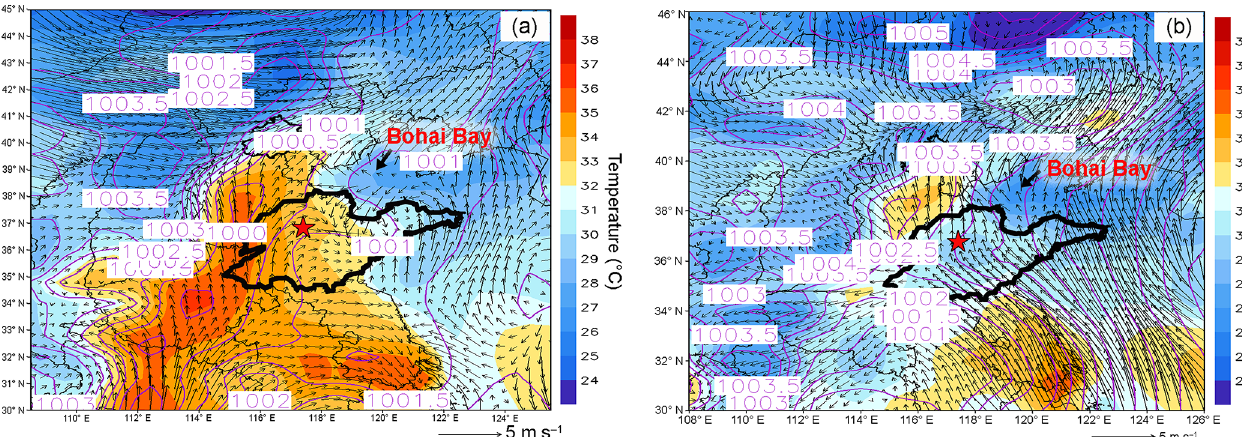
Figure 3. Weather chart at 14:00LT averaged over (a) O 3 episodes and (b) non-episodes. The red star represents Jinan. The dark black line is the boundary of Shandong province. Bohai Bay is located to the northeast of Shandong province. Numbers in the figure are sea-level pressures in units of hectopascal (hPa).